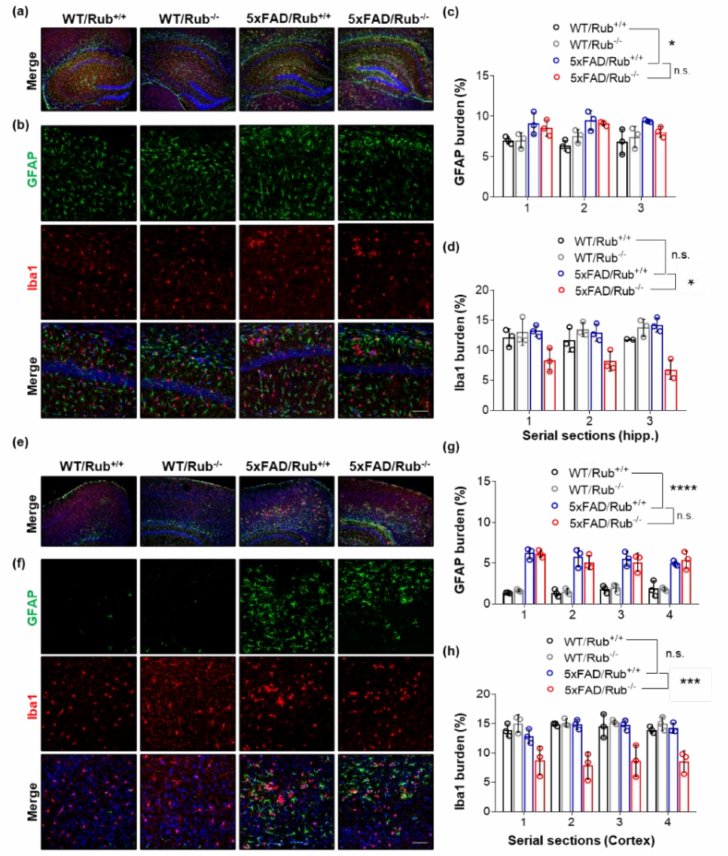
Figure 6. The lack of Rubicon in 5xFAD mice reduces the microglial marker in hippocampus and brain cortex serial sections. ( a , b , e , f ). Representative Z-stack of confocal images of immunocytochem- istry for the detection of astrocytes (GFAP, green), microglia (Iba1, red), and nucleus (DAPI, blue) in serial sections of the hippocampus ( a , b ) and cortex ( e , f ) of wild-type mice with and without regular expression of Rubicon (WT/Rub+/+; WT/Rub − / − ) and 5xFAD mice with and without expression of Rubicon (5xFAD/Rub+/+; 5xFAD/Rub − / − ). Quantification of the fluorescence intensity of astro- cytic marker GFAP (( c ), hippocampus or ( g ), cortex) and microglial marker Iba1 (( d ), hippocampus or ( h ), cortex) in serial sections of the hippocampus of four genotypes analyzed. ( b , f ), scale bar: 50 µ m. Data are mean ± SEM. * p < 0.05; *** p < 0.001; **** p < 0.0001 as determined by repeated-measures ANOVA, n.s., no